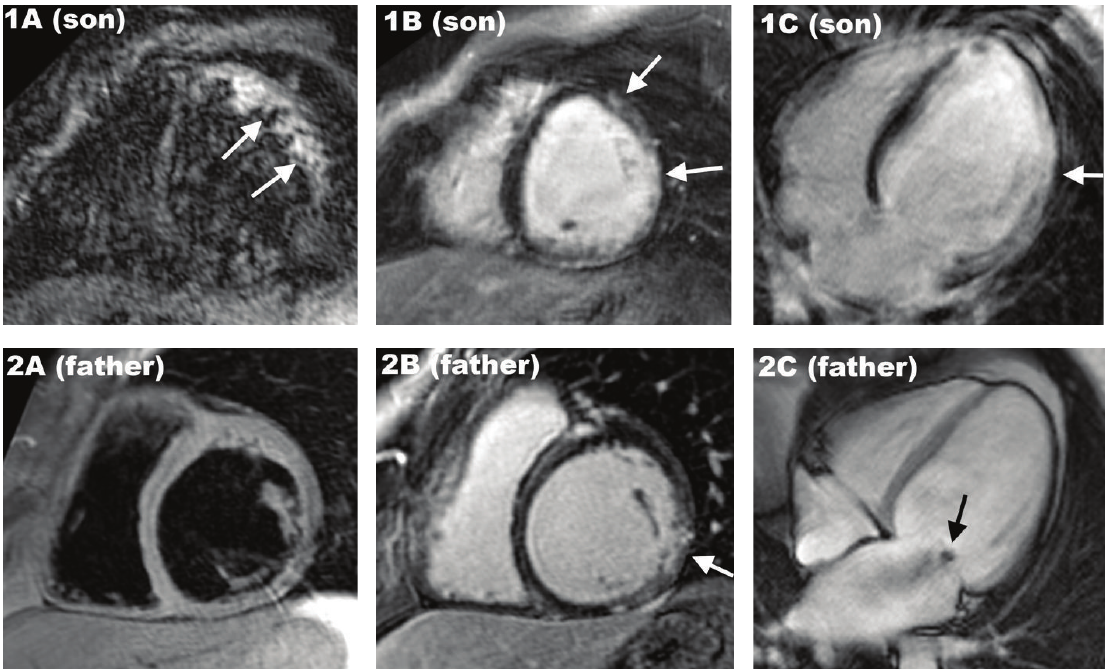
Figure 1: Panel A: son short-axis view T2 weight cardiac MRI with black blood and fat saturation showing bright signal intensity of the lateral wall (white arrows) suggesting myocardial oedema. Panels 1B and 1C: son short-axis view (1B) and 4-chamber view (1C) cardiac MRI showing subepicardial late gadolinium enhancement of the lateral wall (white arrows) suggesting diagnosis of myocarditis. Panel 2A: father short-axis view T2 weight cardiac MRI with black blood and fat saturation without signal abnormality. Panel 2B: father short-axis view (1B) cardiac MRI showing subepicardial late gadolinium enhancement of the inferolateral wall (white arrow) suggesting diagnosis of myocarditis. Panel 2C: father four-chamber view cine-MRI during the first part of the systole showing dilated cardiomyopathy with functional mitral regurgitation (black arrow).